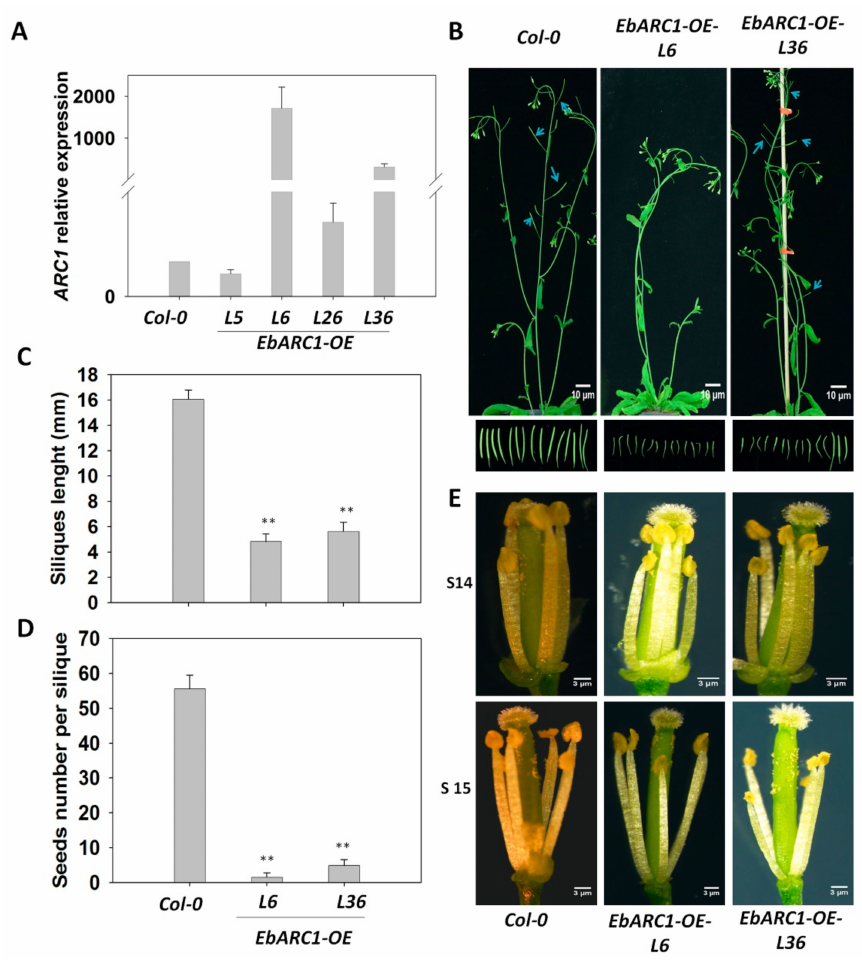
Figure 4. Expression of EbARC1 resulted in infertility in A. thaliana. ( A ) qRT-PCR characterization of EbARC 1 expression in four independent transgenic lines. ( B ) Phenotypes of EbARC 1 overexpressed lines and wild type. ( C ) Silique lengths and ( D ) seed numbers of EbARC 1 overexpressed lines and wild type. ( E ) Phenotypes of stamen and stigma in both overexpressed lines and wild type. Arrows indicate position of siliques. Error bars denote SDs (** p <